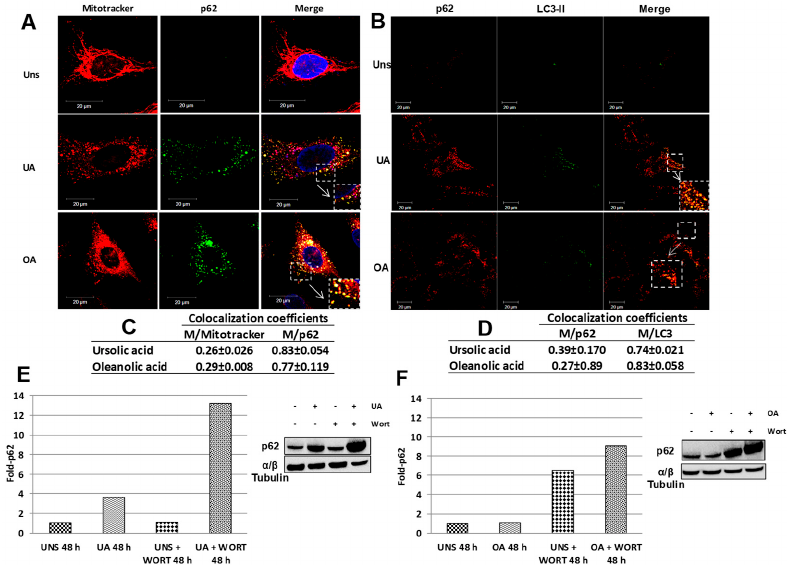
Figure 4. p62 colocalizes with fragmented mitochondria and LC3-II. ( A ) A549 cells unstimulated (Uns) or stimulated with 10 µ g / mL of ursolic acid (UA) or 20 µ g / mL of oleanolic (OA) for 48 h. The cells were stained with MitoTracker Green (200 nM), fixed with 4% paraformaldehyde and washed with PBS. The cells were incubated with anti-p62 at 4 ◦ C overnight and finally incubated with secondary antibody at 37 ◦ C for 4 h. The framed areas show the colocalization of p62 with fragmented mitochondria, and a magnification of these areas is displayed in the large squares. ( B ) A549 cells stimulated with 10 µ g / mL of ursolic acid (UA) or 20 µ g / mL of oleanolic (OA) for 48 h were fixed with 4% paraformaldehyde and washed PBS, and subsequently incubated with anti-LC3 A / B and anti-p62 at 4 ◦ C overnight. Finally, the cells were incubated with secondary antibodies at 37 ◦ C for 4 h. Squares and white arrows show the colocalization of p62 and LC3-II. ( C ) The Mander´s coefficients from 0 to 1 (0 = non-overlapping images and 1 = colocalized images) were determined, and the colocalization of Mitotracker with p62 (M / Mitotracker) and p62 with Mitotracker (M / p62) were calculated. ( D ) The colocalization degree of p62 with LC3-II (M / p62) and LC3-II with p62 (M / LC3-II) was determined through Mander´s coefficients from 0 to 1. ( E , F ) The plots showed the western blot analysis to detect p62 protein induced by ursolic or oleanolic acid in A549 cell without or with 5 mM wortmannin (WORT). The quantitative analysis of a representative experiment is